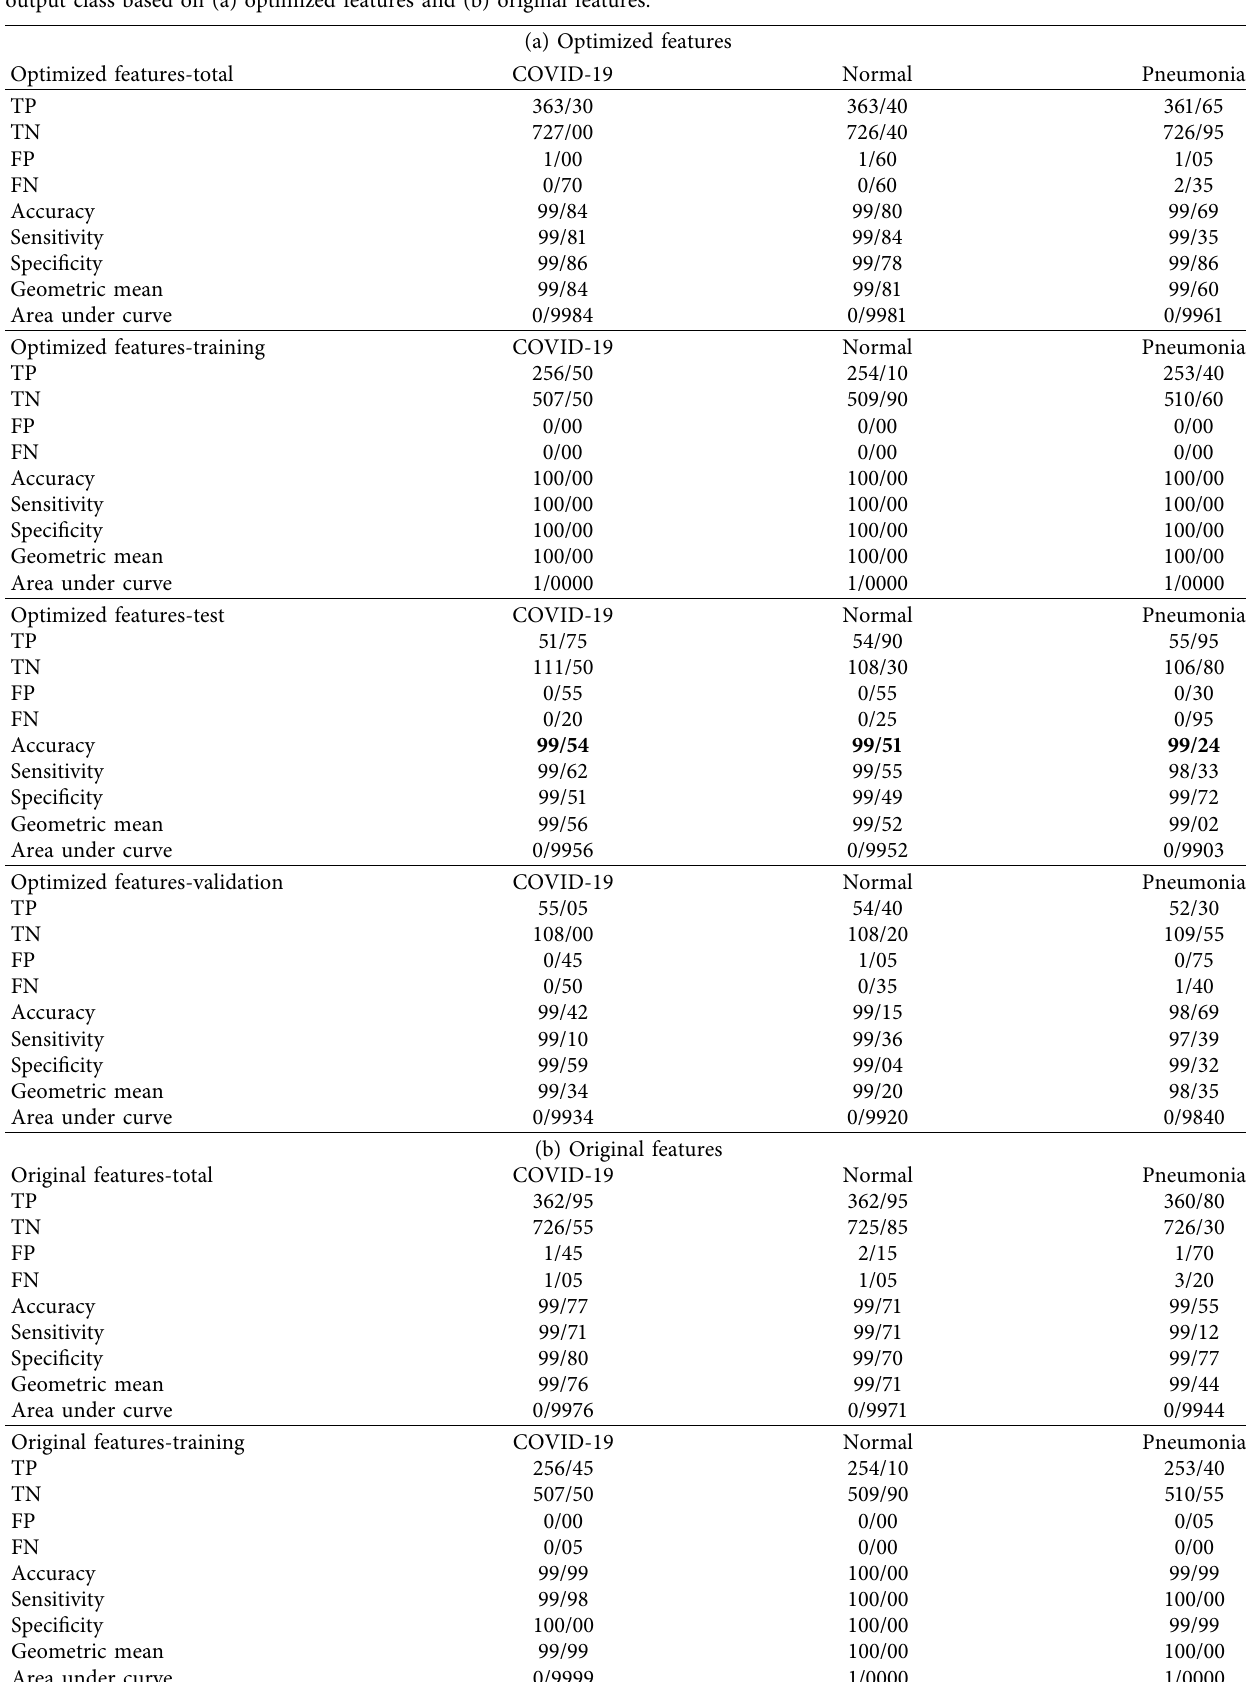
Table 2: Comparison of indicators (TP, TN, FP, FN, accuracy, the area under curve, sensitivity, specificity, and geometric mean) for any output class based on (a) optimized features and (b) original